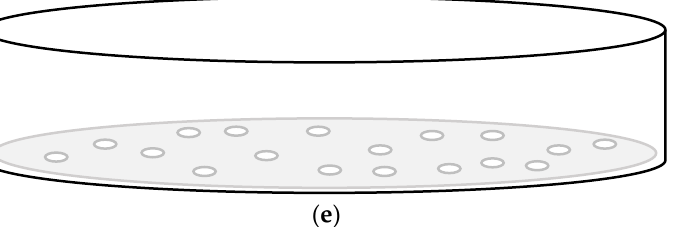
Figure 3. Schematic illustration of the virucidal testing workflow. ( a ) Application of phage suspension (100 µ L) on cover slides. ( b ) Drying at room temperature and subsequent UV-C irradiation. ( c ) Rinsing off the surface off the test bodies using 1 mL of peptone saline solution. ( d ) Using dilution series and mixing 1 mL of each dilution with 100 µ L peptone saline solution containing 1 × 10 8 Escherichia coli . Plating the suspension (incubation at 37 °C for 24 h). ( e ) Plaque counting.